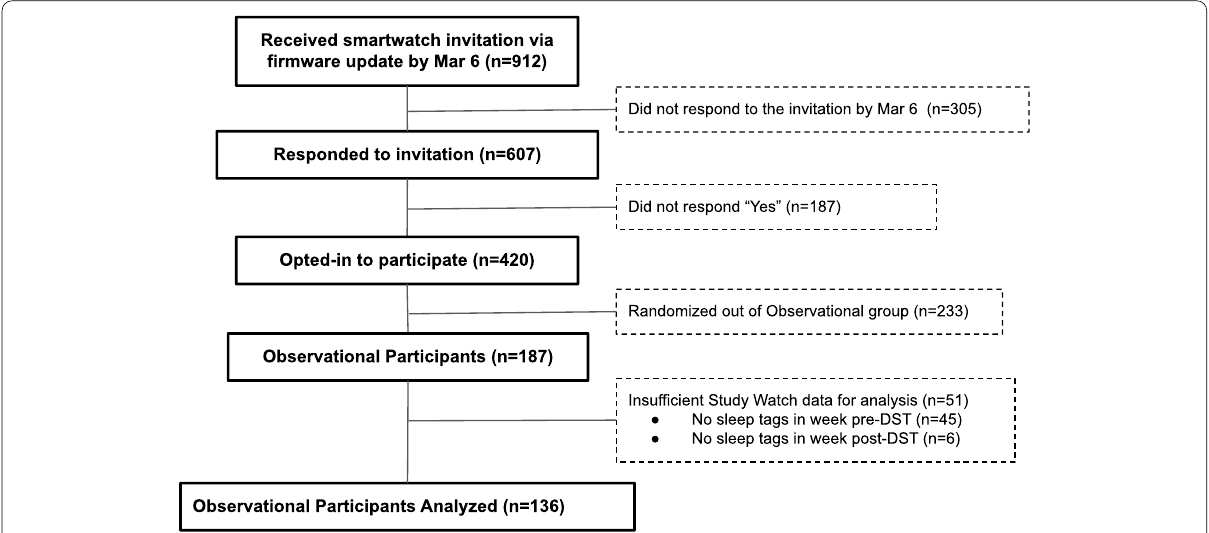
Fig. 1 Flow chart of the steps followed for the inclusion of participants in this analysis. In summary, to be included for analysis, participants must have opted in by March 6, 2021 and provided a minimum of one night of data both in the week before and the week after the DST transition occurring at 2:00 am on March 14, 2021